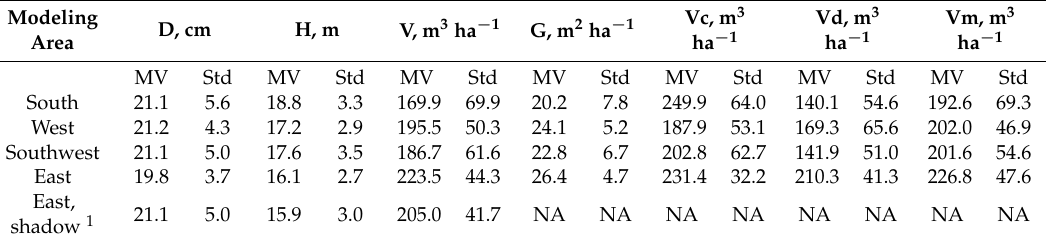
Table 2. Field data statistics for modeling areas. MV = mean value, Std = standard deviation, n = number of plots. D = mean diameter at breast height, H = mean tree height, V = mean volume, G = basal area, Vc = mean volume of the coniferous forest class, Vd = mean volume of the deciduous forest class, Vm = mean volume of the mixed coniferous forest